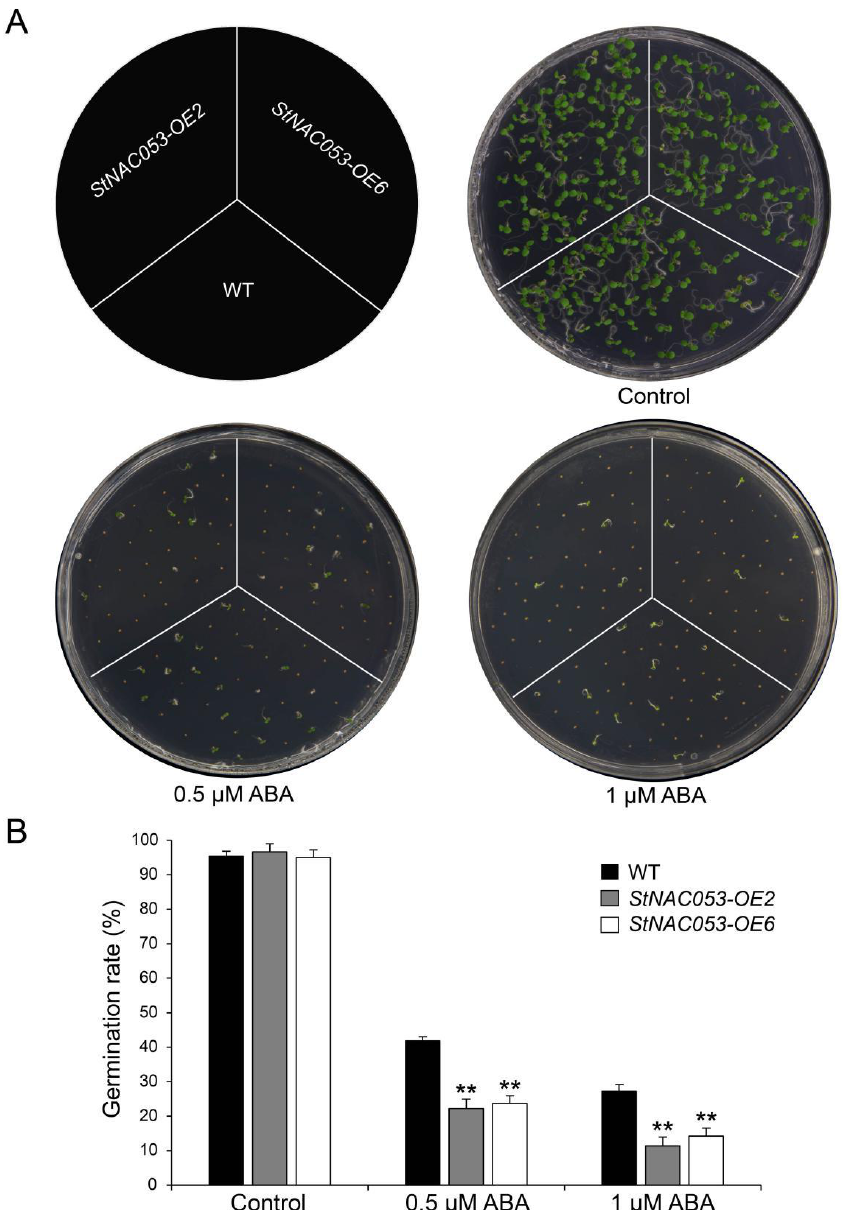
Figure 6. Comparison of the ABA sensitivity between StNAC053 overexpression and wild-type Arabidopsis . ( A ) Seed germination assay between StNAC053 overexpression and wild-type Arabidopsis under 0.5 and 1 μM ABA treatments. The seed germination rates were recorded six days after sowing. ( B ) The statistics of germination rates under normal condition, 0.5 and 1 μM ABA treatments. WT, wild-type. The data were means ± SD from three independent replications. ** p < 0.01 ( t- tests).